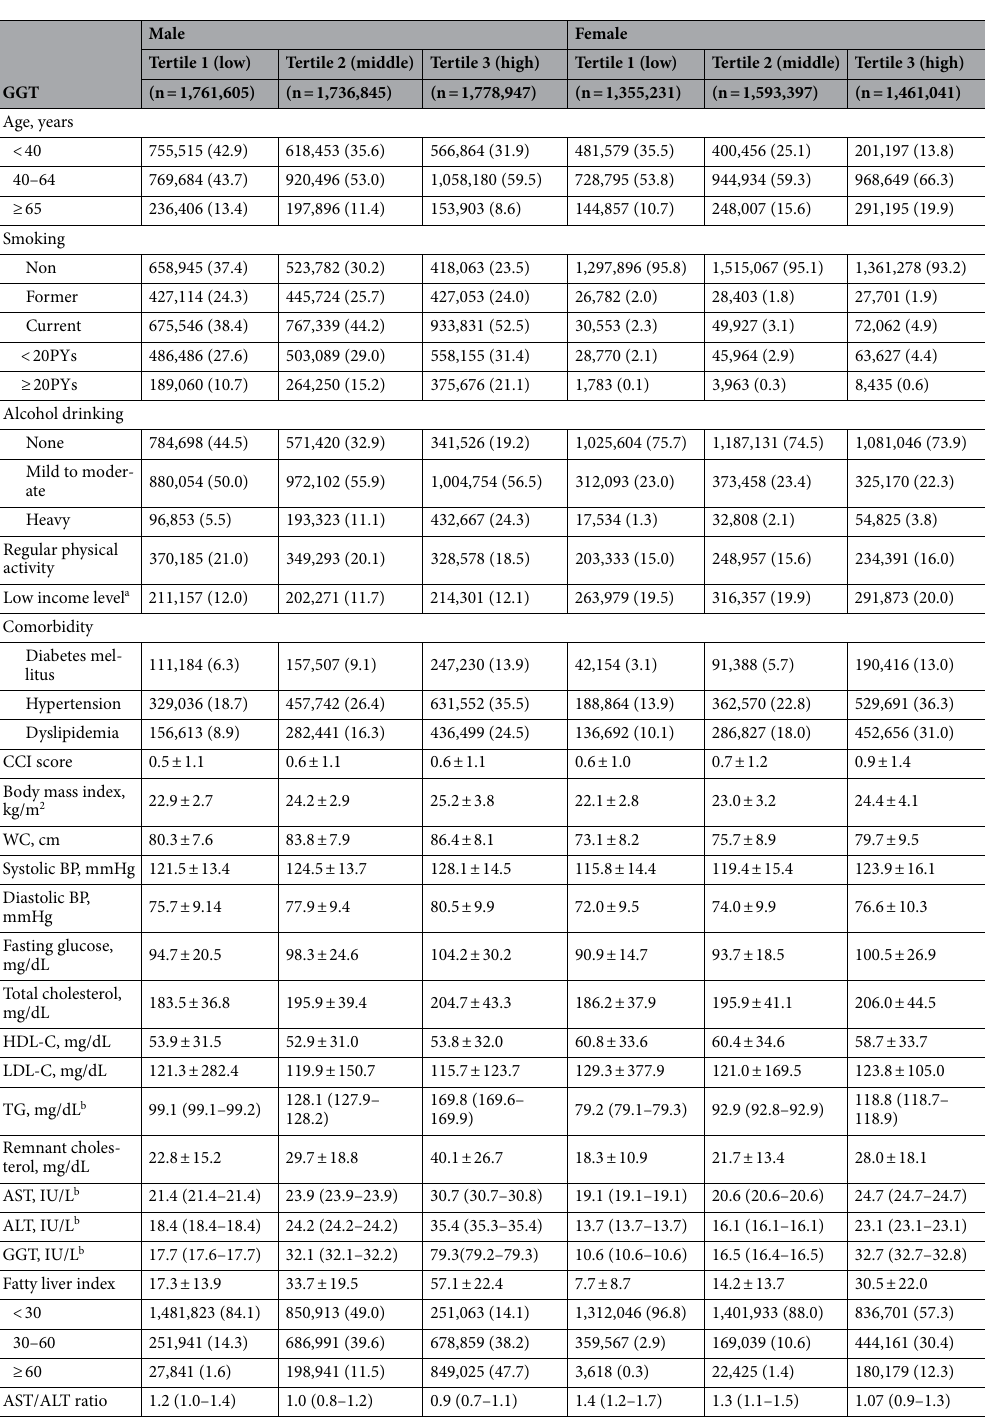
Table 1. Baseline characteristics according to tertiles of gamma-glutamyl transferase (GGT) by sex. a Lower 20% of income. b Geometric mean with 95% confidence interval. Values are presented as mean ± standard deviation or median (range) for continuous variables and number (%) for categorical variables. CCI, Charlson comorbidity index; WC, waist circumference BP, blood pressure; HDL-C, high density lipoprotein- cholesterol; LDL-C, low density lipoprotein -cholesterol; TG, triglyceride; AST, aspartate transaminase; ALT, alanine transferase; GGT, gamma-glutamyl transferase. P- values for all variables within each sex were < 0.001,